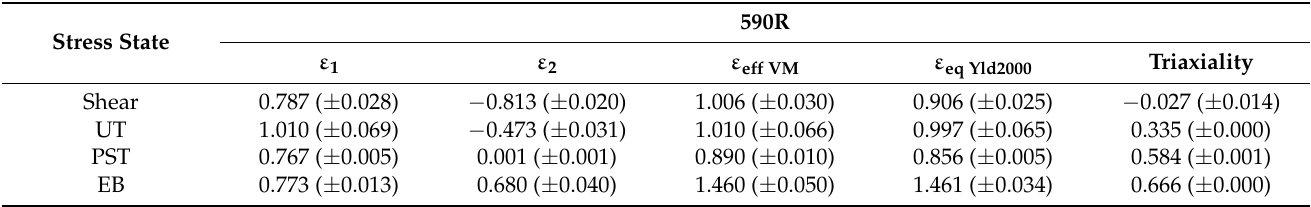
Table A3. Summary of fracture strains for the 590R AHSS. Note that the von Mises effective strain corresponds to the absolute strain assuming a linear strain path. The Barlat Yld2000 equivalent strain corresponds to the accumulated work- conjugate equivalent strain integrated along the measured strain path and accounts for material anisotropy.